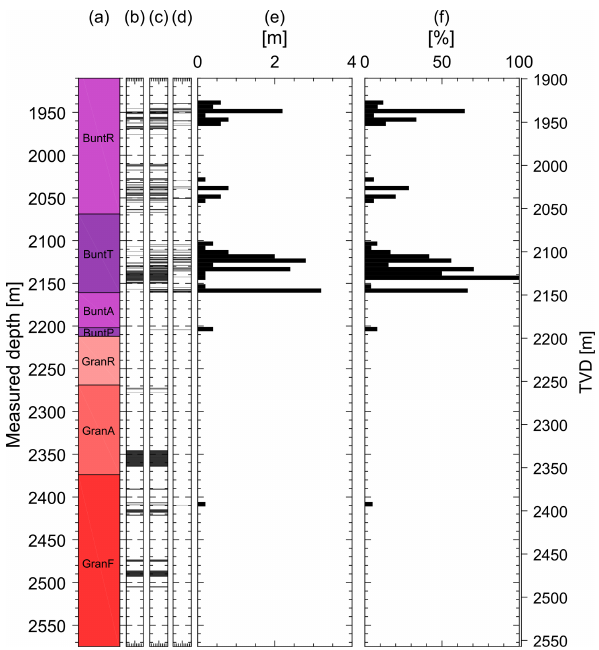
Figure 9. Evolution of breakout width in the GRT-1 borehole as a function of measured depth (MD) or vertical depth (TVD). (a) Sim- plified lithologies along the GRT-1 borehole (see Fig. 8 for the legend). (b) Width increase between the 2012–2013 time inter- val (black circles) and the 2013–2015 time interval (red crosses) presented as a function of the vertical depth. (c) Histograms in 2 ◦ classes of breakout width changes for the 2012–2013 interval (black) and the 2013–2015 interval (red). Table 3. Mean density retained for each lithological layer and ver- tical depth (TVD) in each